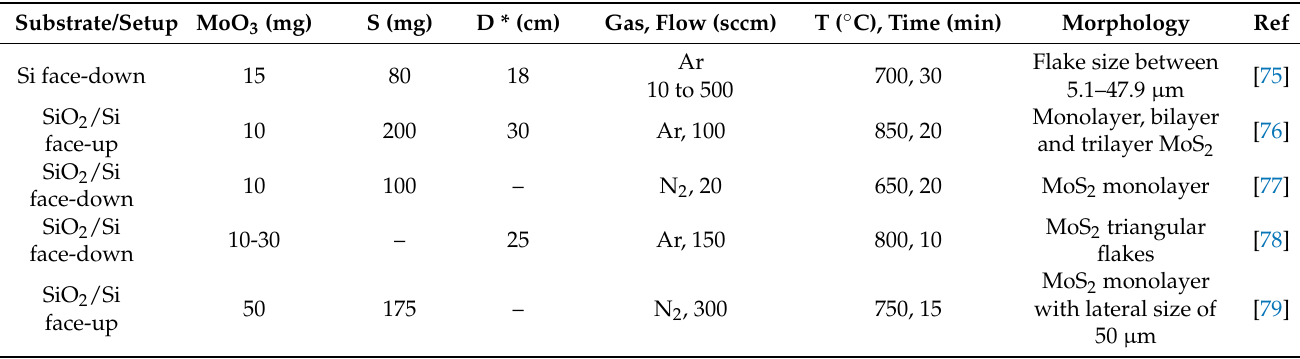
Table 3. Examples of TVD grown MoS 2 along with their relevant processing conditions (* D is the distance between the MoO 3 and S powders inside the tubular